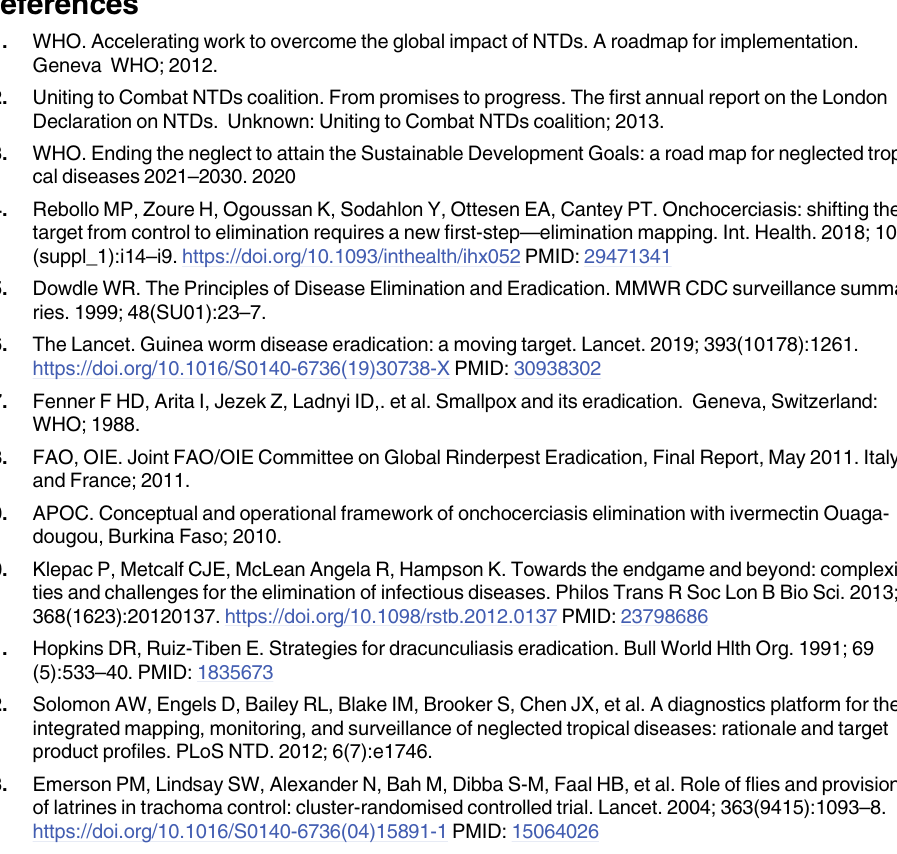
S2 Table. List of papers eligible for